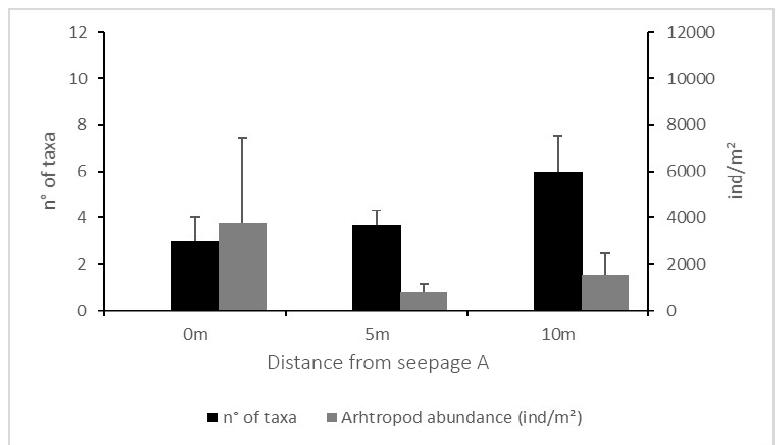
Figure 6. Average and Standard Error of the number of taxa and the number of individuals per m 2 found along the transect at 0 m (soil surrounding seepage A), 5 m and 10 m from seepage A. No letters above bars mean no significant differences within transects ( p > 0.05). Water 2020 , 12 , x FOR PEER REVIEW